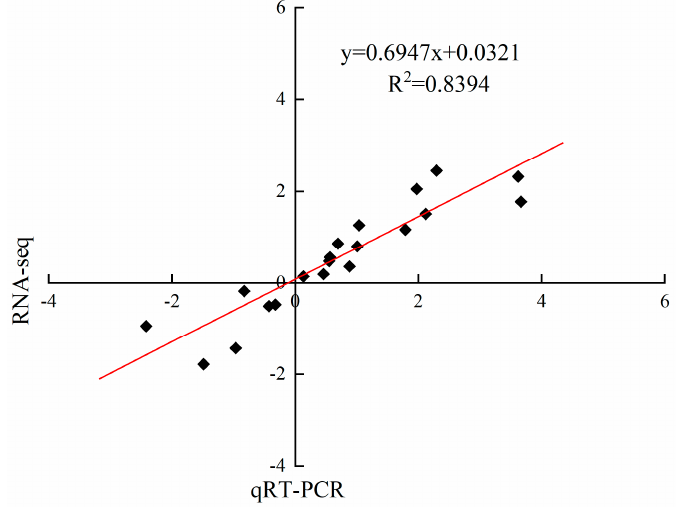
Figure 6. Correlation of fold change analyzed by RNA-Seq (x axis) and qRT-PCR (y axis). The values of RNA-Seq and qRT-PCR were derived from Supplementary Table S2 and Figure S1.